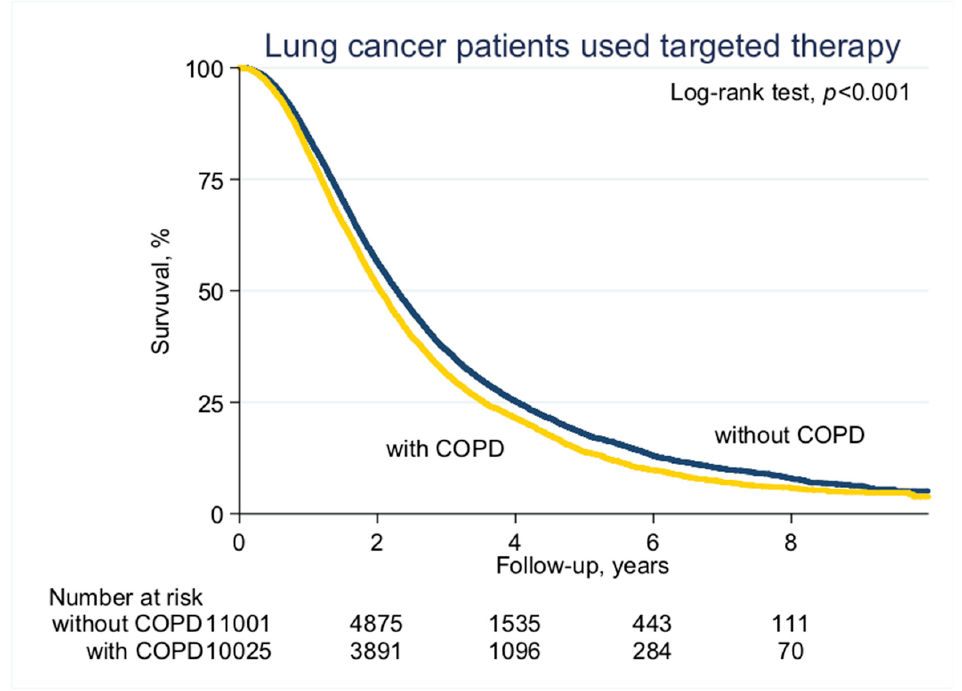
Figure 3. Overall survival curve of COPD and non-COPD cohorts (before PS matching).